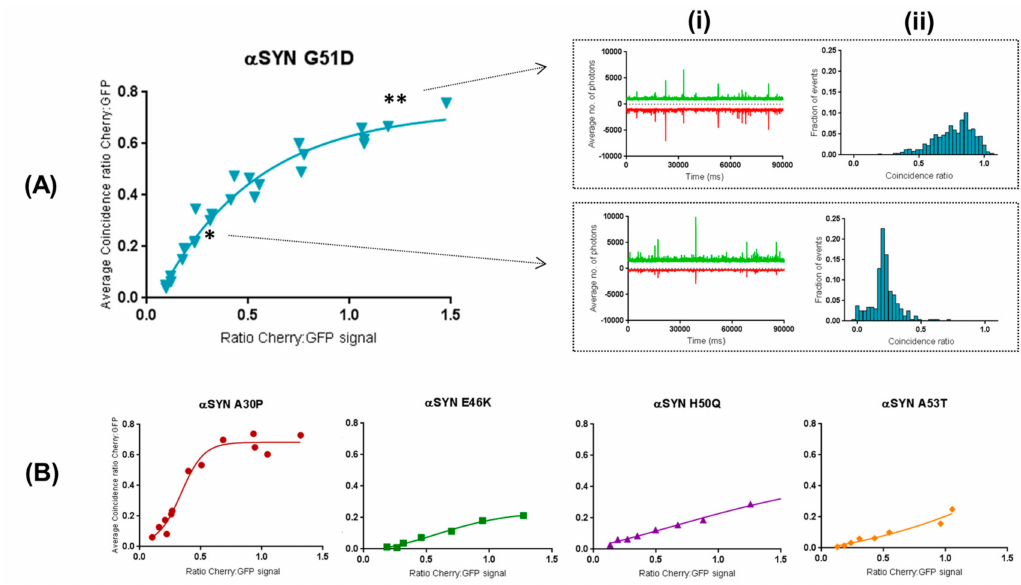
Figure 4. Two-color coincidence applied to the β : α titration range validates affinity differences between aggregated forms of synucleins. ( A ) Two-color coincidence analysis was performed for all 90 s traces ( i ) corresponding to the different concentration ratios tested. The distributions of coincident events ( ii ) were averaged and averages of coincidence ratios were plotted across the β : α ratios as exemplified by α S G51D (“* → ” ratio = 0.25; and “** → ” ratio = 1.2). ( B ) The same plots were acquired for all mutant forms of α S revealing two types of